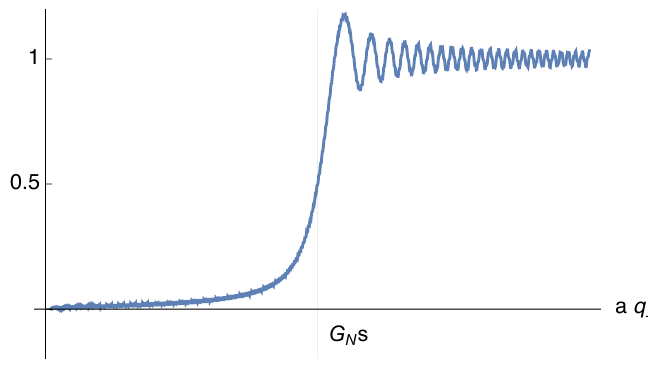
Figure 3 . Plot of the ratio of the spin correction to the leading order term. Those grow to reach order 1 correction around aq ⊥ ∼ G N s . To produce this specific plot, we used typical values of s and a , G N = 1 , s = 500 , a = 10